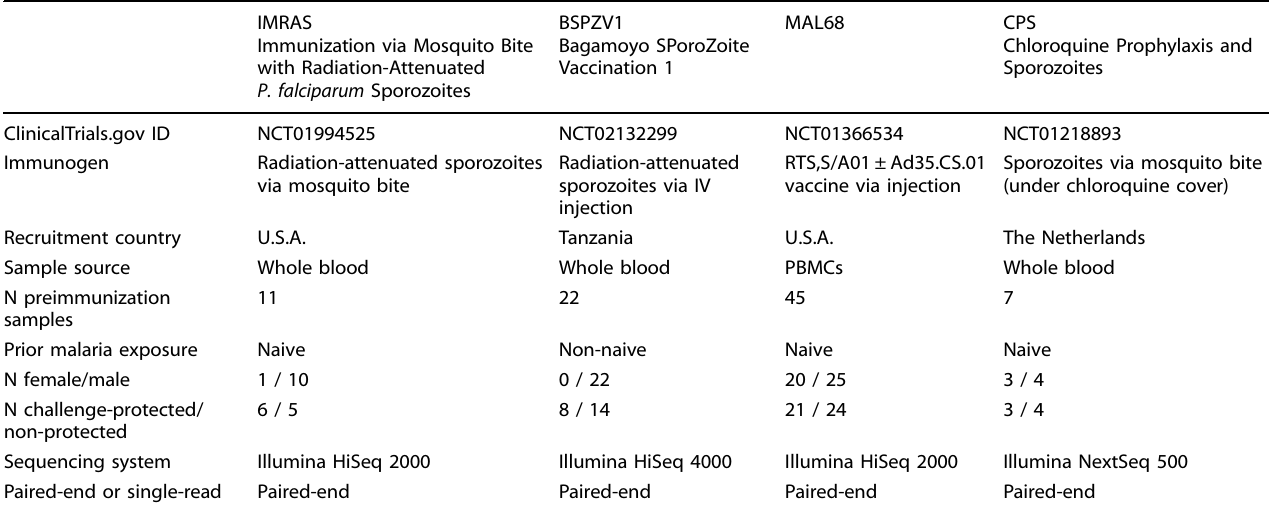
Table 1. Characteristics of the four clinical trials that generated transcriptomic data used to identify preimmunization correlates of